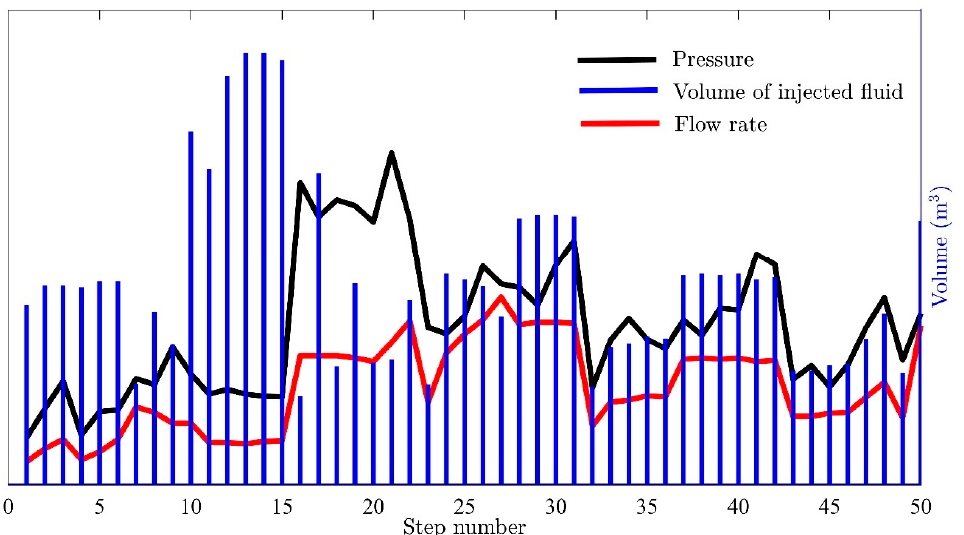
Figure 5. Daily flow rate, injection pressure, and injected volume of the hydraulic testing/stimulation operation on UD − 1 from September 2020 until January 2021. Here flow rate, pressure, and injection volume are hidden for commercial issues. The black and blue colors indicate the pressure and volume of the injected fluid.